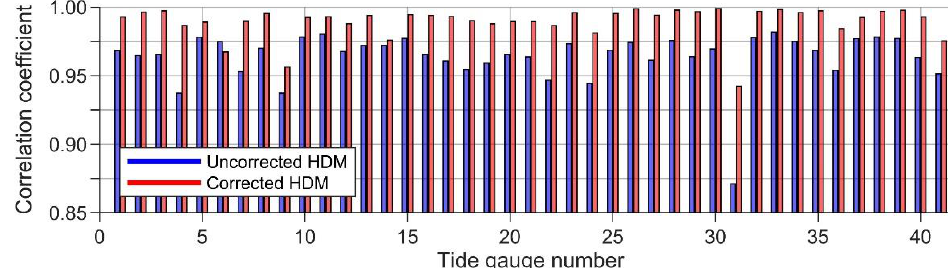
Figure 3. Correlation coefficients between TG and HDM data at the TG locations (based on all 792 h of used data, cf. Table 1). For better readability, only the top of the vertical scale is shown.